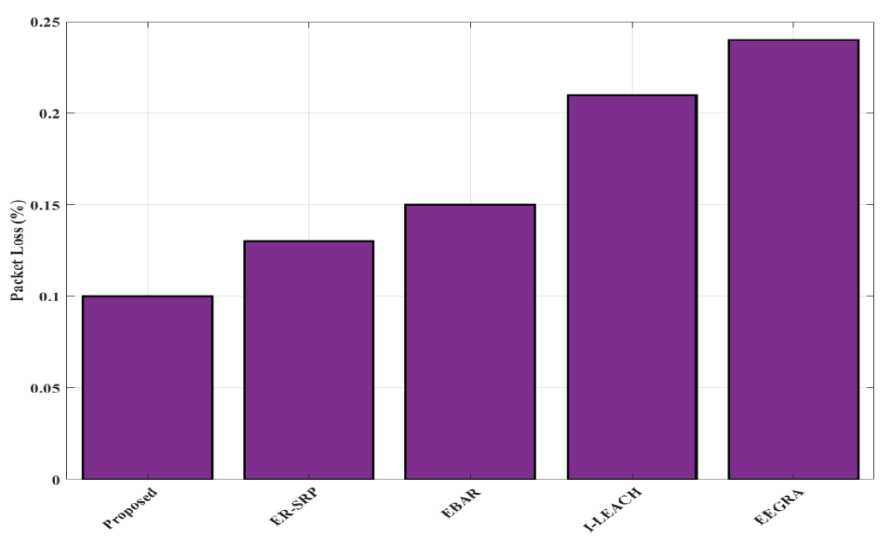
Figure 13. Comparison of packet loss.